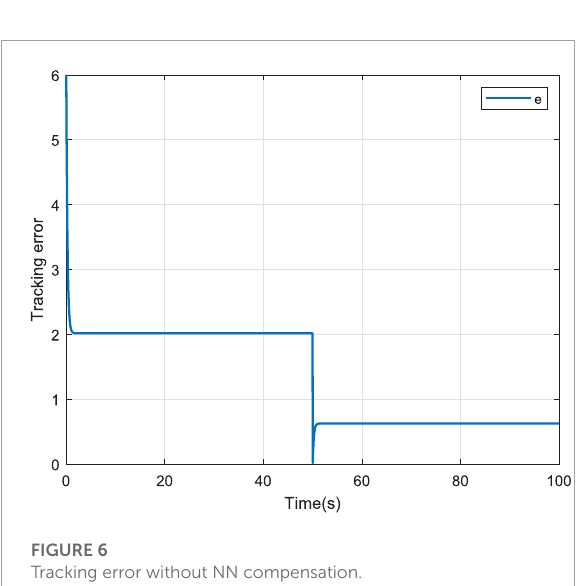
FIGURE 6 Tracking error without NN